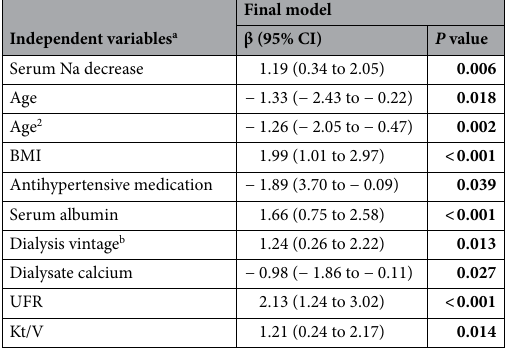
Table 4. Factors significantly associated with SBP decrease index (%) in the final multivariate model. SBP systolic blood pressure, Na sodium, BMI body mass index, UFR ultrafiltration rate. a Standardized to a mean of 0 and a SD of 1. b Log transformed. Bold values correspond to p < 0.05.